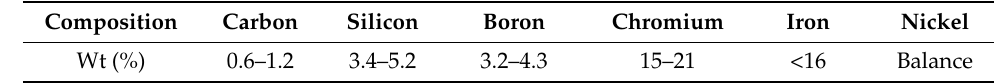
Table 2. Chemical properties of Ni63 powder.